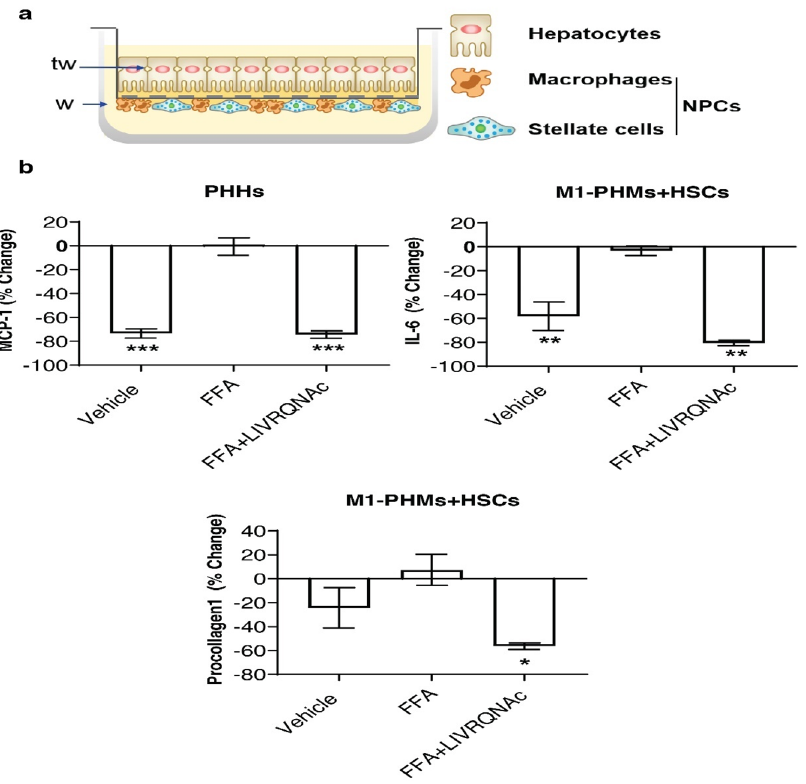
Figure 4. LIVRQNac treatment impacts markers of inflammation and fibrosis associated with NASH in a primary human multicellular system. ( a ) Cartoon scheme of liver multicellular in vitro system of primary human cells coculture in a transwell set up consisting of hepatocytes (top of the transwell: tw) and NPCs macrophages and HSCs (bottom of the tw; w). Adapted with permission from Ref. no. 31, American Society for Clinical Investigation using a CC BY license. ( b ) Secreted inflammatory markers (MCP-1, IL-6) and fibrosis marker (procollagen 1) were measured in the coculture supernatant collected from either the transwell (tw; PHHs) or the well (w; M1-PHMs + HSCs) side after 24 h treatment with either vehicle (without FFA) or with FFA, with or without additional LIVRQNac (30x of the human plasma concentration for LIVRQ and 7.5 mM Nac, applied 24 h before insult; FFA + LIVRQNac). Data expressed in percentage relative to FFA-treated cells represents the mean of two to three technical replicates from two individual donors. Error bars represent ± SEM. *** p < 0.001; ** p < 0.01; * p < 0.05 versus FFA. Analysis was performed using GraphPad Prism version 9.0.1 for Windows, GraphPad Software, San Diego, California USA, www. graph pad. com. The graphs were assembled using Adobe Illustrator CC 2019, www. adobe. com. FFA lipotoxic insult (0.25 mM saturated free fatty acids [2:1 oleate: palmitate] + 1 ng/mL TNF-α), IL interleukin, MCP-1 monocyte chemoattractant protein-1, Nac N -acetylcysteine, NPC nonparenchymal cell, PHH primary human hepatocyte, SEM standard error of the mean, TNF-α tumor necrosis factor-alpha, tw top of transwell, w bottom of